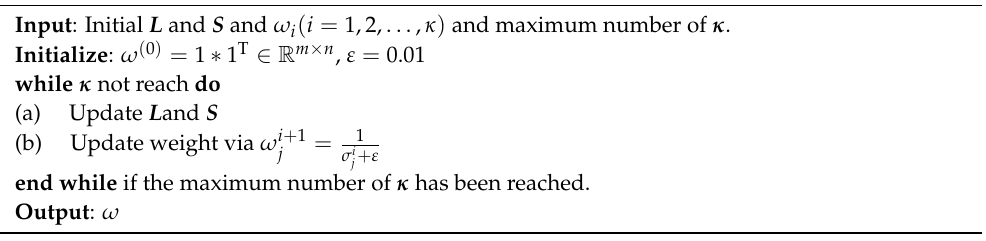
Algorithm 1 Algorithm for update